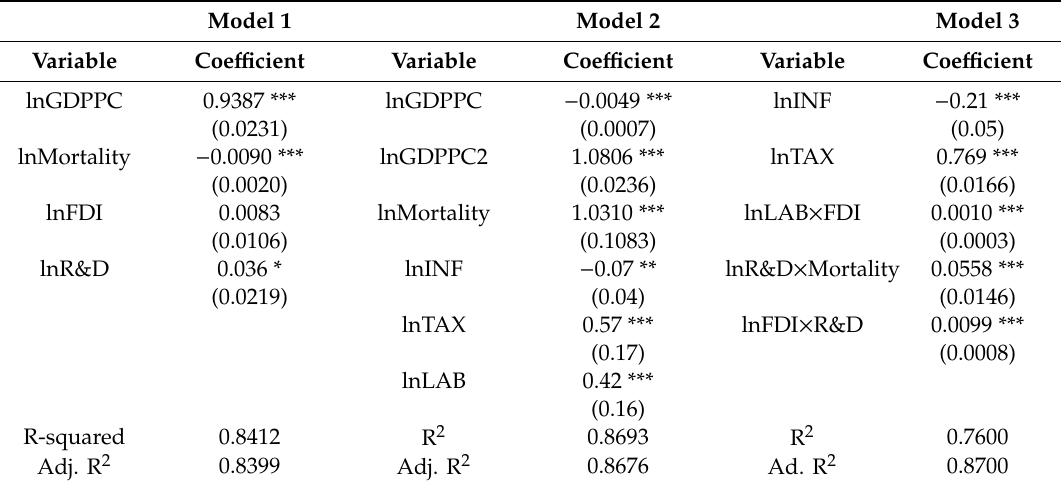
Table 4. Panel results for ordinary least squares regression